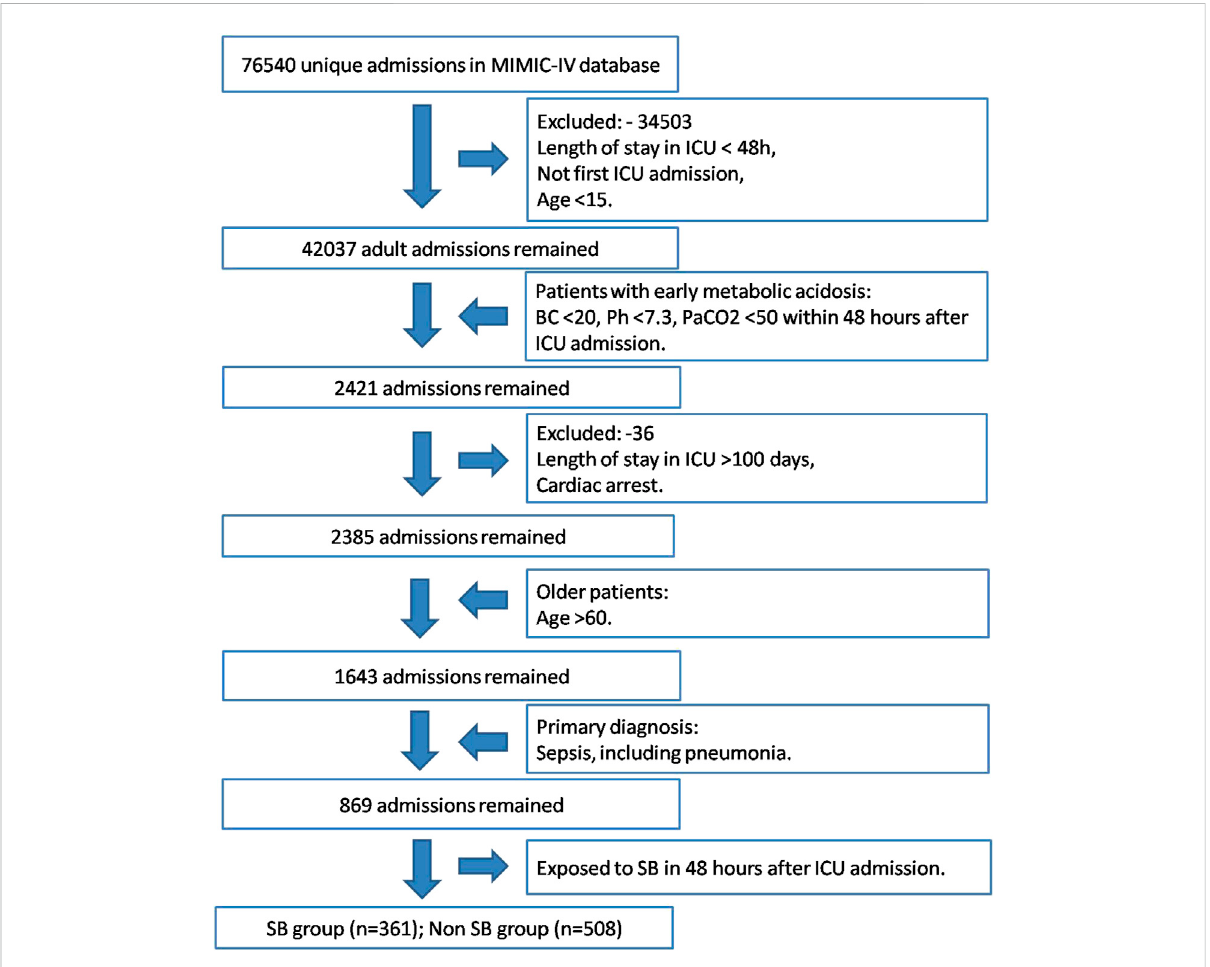
FIGURE 1 Study cohort selection work fl ow of MIMIC-IV database based on the designed inclusion and exclusion